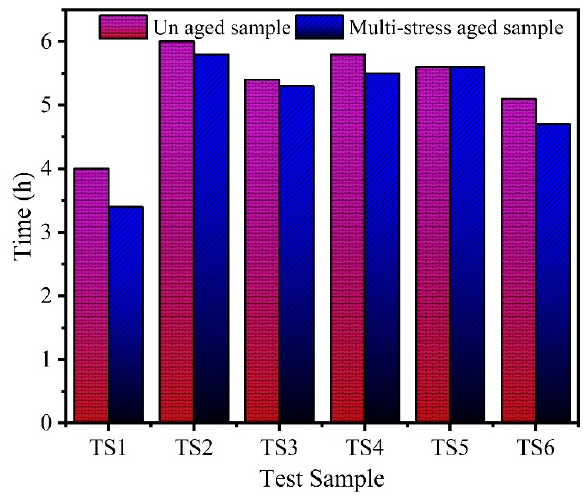
Figure 6. Tracking time of aged and virgin samples.